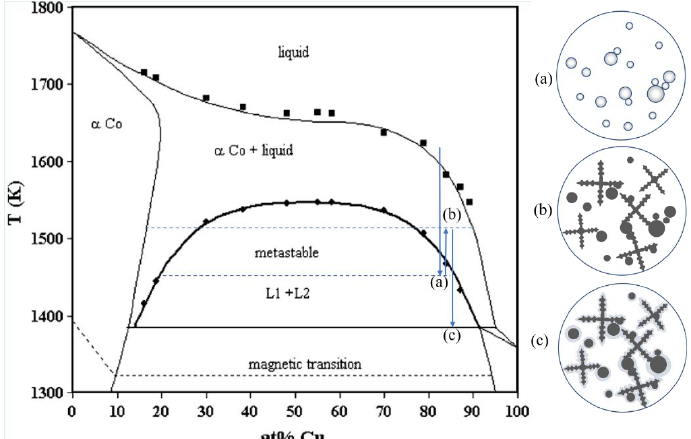
Figure 4. This is a phase diagram schematic of Cu-Co (reproduced from [29], with permission from Springer Nature, 2018). and the schematic diagram of the solidification process: ( a ) Nucleation, collision, and coagulation of Co-rich droplets; ( b ) Nucleation and growth of α -Co dendrites, and Co-rich droplets also turn to be α -Co; ( c ) Peritectic reaction between α -Co and Cu-rich